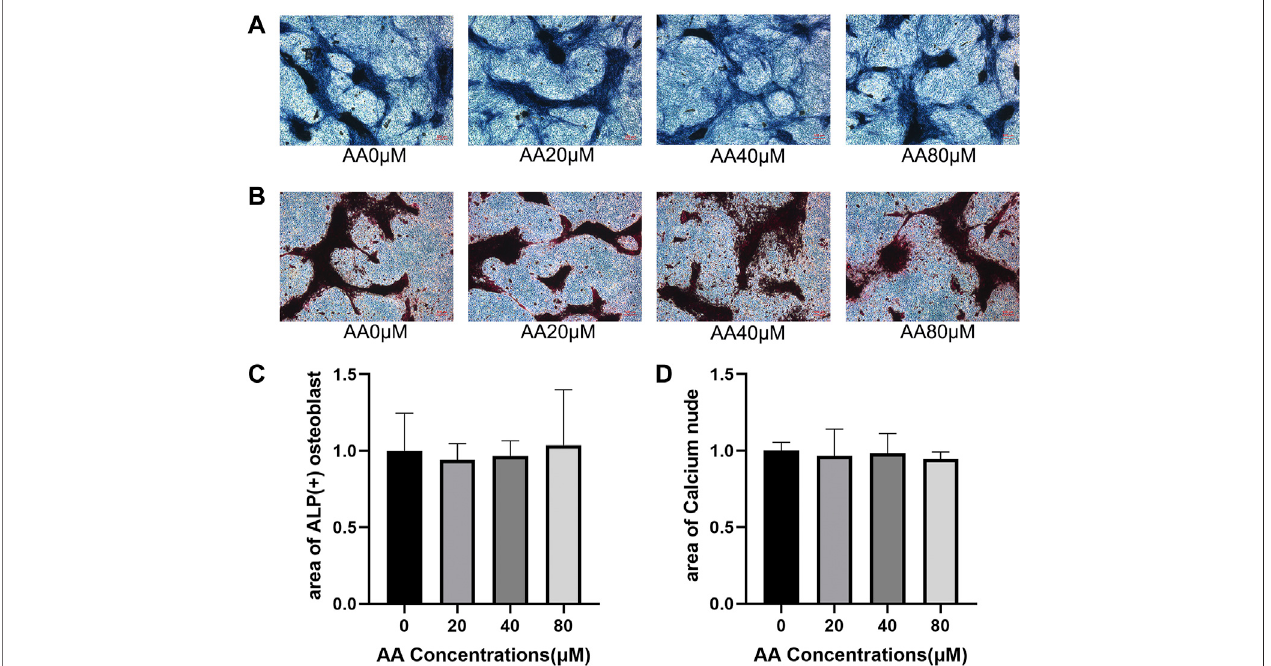
FIGURE 4 | Asiatic acid could not signi fi cantly enhance osteoblast differentiation and mineralization. (A) Representative images of alkaline phosphatase staining showing that the effect of asiatic acid on osteogenic differentiation. After 7 days of osteogenic induction with or without asiatic acid, osteoblasts were observed by alkaline phosphatase staining kit ( n = 3). (B) Following 21 days of osteogenic induction, mineralized nodules were evaluated by alizarin red staining kit ( n = 3). (C) Quantitative analysis of the percentage of ALP-positive osteoblasts. (D) Quantitative analysis of the percentage of mineralized nodules. All values are presented as the mean ± SD ( n =